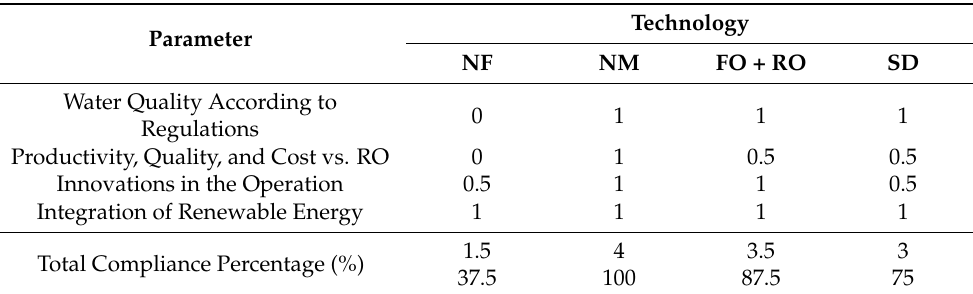
Table 7. Results of the comparative evaluation of the industrial scale-up potential for NF, NM, FO + RO, and